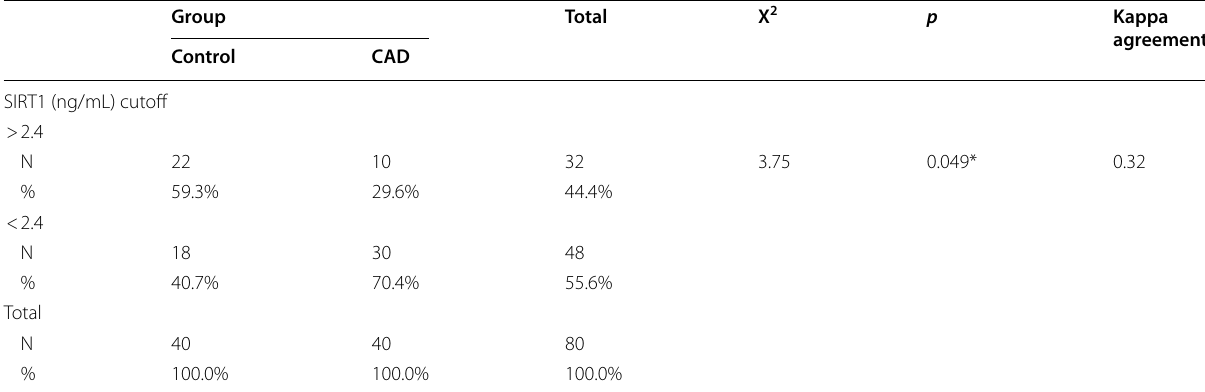
Table 3 Association and agreement between Sirtuin1 cutoff levels and coronary artery disease